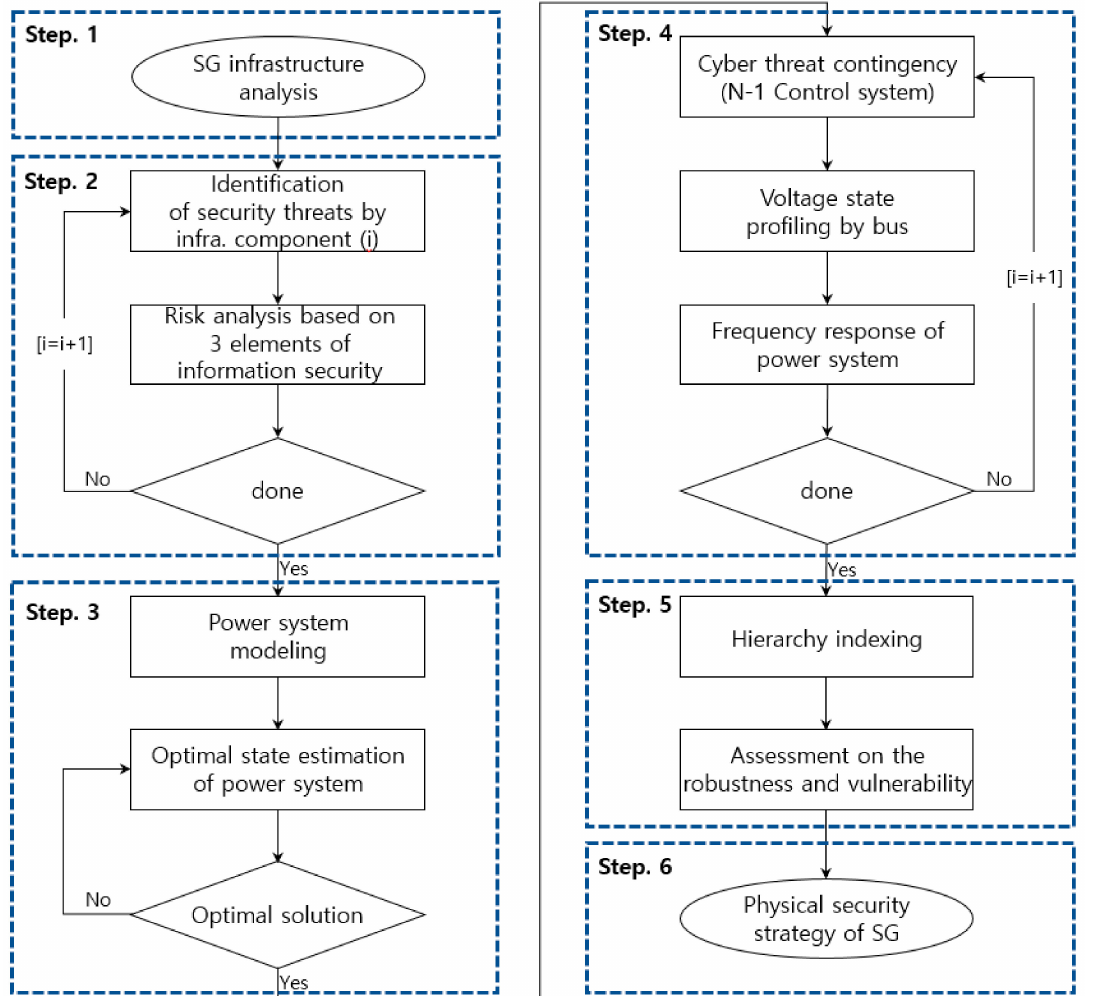
Figure 2. Evaluation process on risk impact of cybersecurity